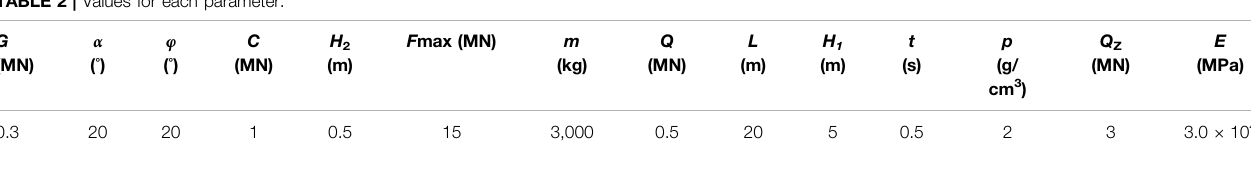
TABLE 2 | Values for each